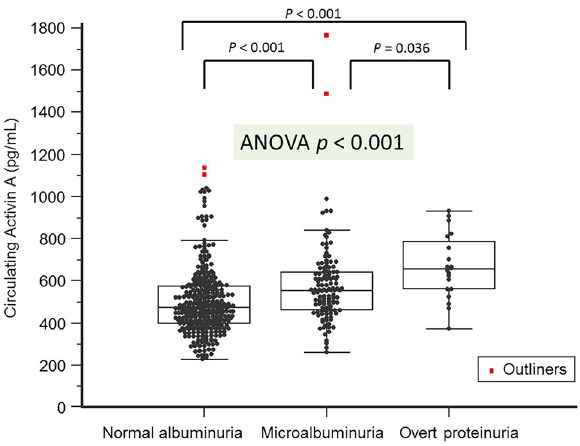
Figure 1. Serum activin A elevation is positively correlated to the severity of